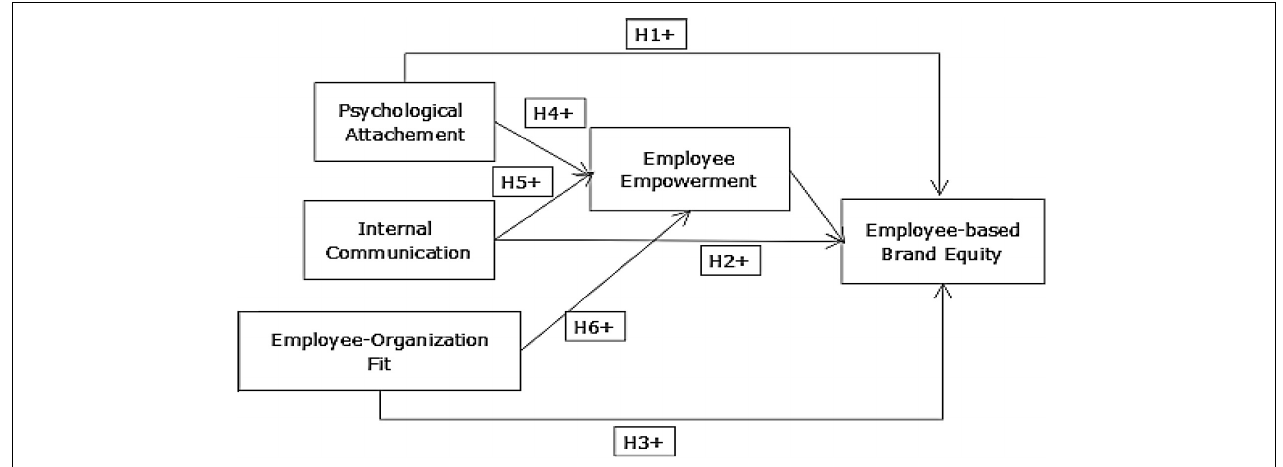
FIGURE 1 | Conceptual